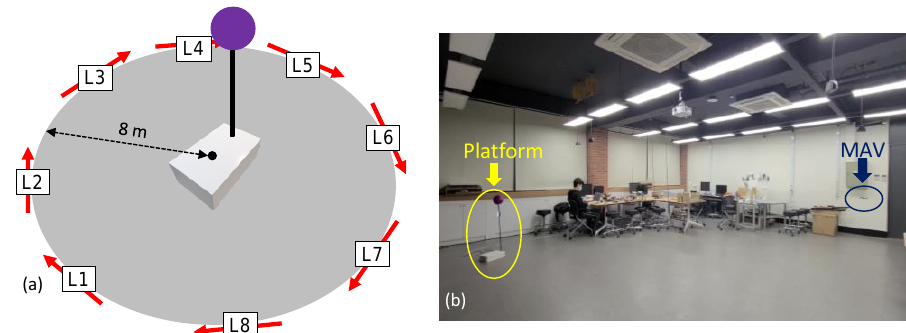
Figure 8. Experimental setup of the autonomous landing system. ( a ) Configuration of the landing experiments with arrows at each location showing the direction where the MAV is facing; ( b ) plat- form and MAV at the start of the autonomous landing control.